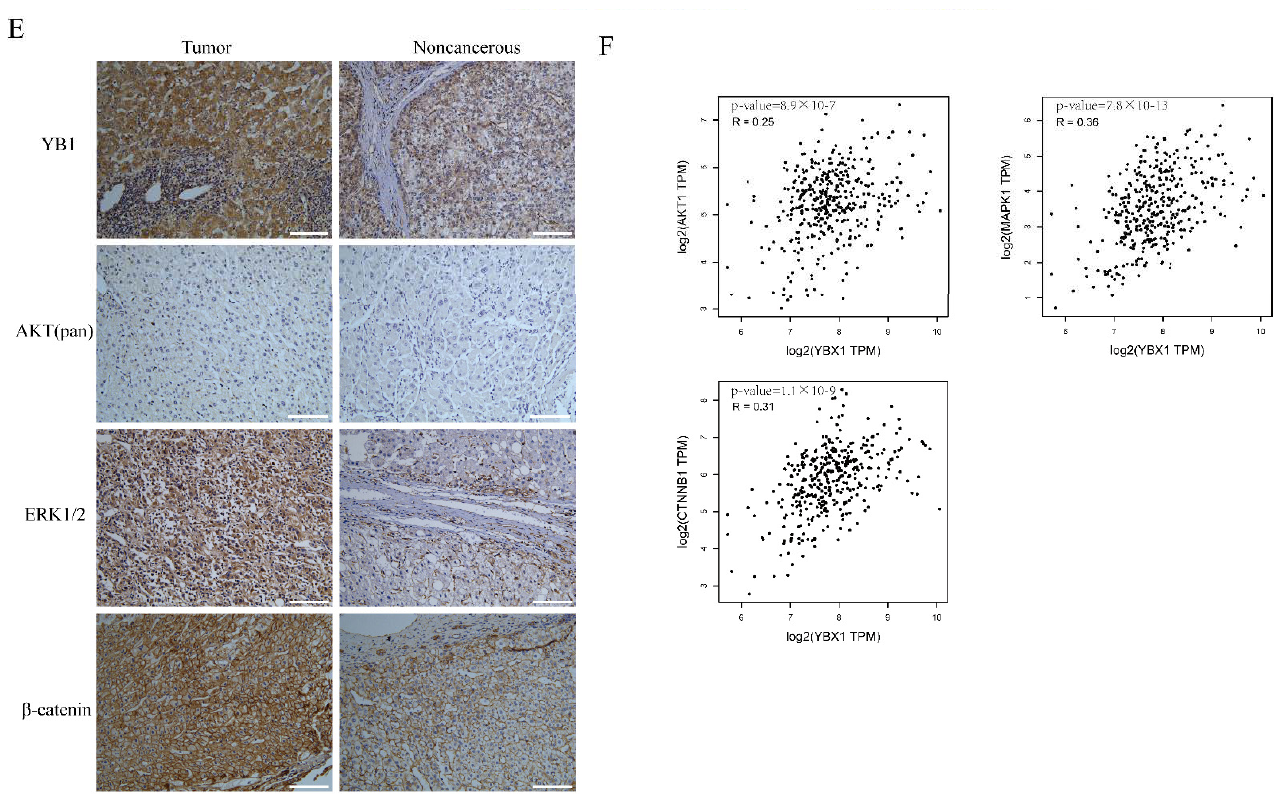
Figure 6. The lncRNA NEAT1 promotes the growth of liver cancer in vivo. NEAT1 -KD HepG2 cells were inoculated into the subcutaneous tissue of nude mice. The tumor picture ( A ), the tumor volume ( B ), and tumor weight ( C ) are shown and compared among the groups; * is p < 0.05 and ** is p < 0.01. ( D ) Immunohistochemistry (IHC) staining of β -catenin in the tumors. The activation of the WNT/ β -catenin pathway depends on the localization of β -catenin. The IHC staining of β -catenin overlay with the nuclear was displayed below. Scale bar: 75 µ m. ( E ) IHC analysis to detect the expression of YB1, AKT, ERK, and β -catenin in liver cancer samples from patients. Scale bar: 100 µ m. ( F ) The correlation between YB1 and AKT, ERK, and β -catenin in LIHC from the GEPIA database. The R values and p values are from Pearson’s correlation